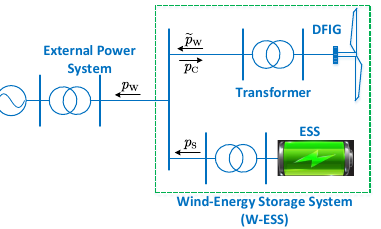
Figure 1. The W-ESS structure with a wind farm and an integrated ESS